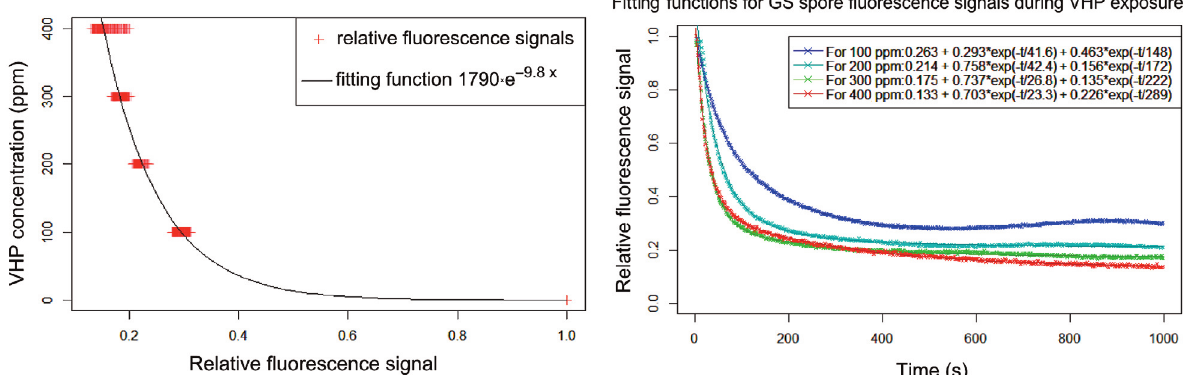
Fig. 4. Left graph – VHP concentration values plotted as a function of the relative fluorescence intensity levels (compared to the initial fluorescence level) that were recorded after >5 minutes from the beginning of VHP exposure. The single exponential fitting seems to describe really well the GS spores during the VHP decontamination process. Right graph – intensity of relative fluorescence levels in the Trp-like spectral region as a function of time at 100 ppm, 200 ppm, 300 ppm and 400 ppm VHP concentrations. Data was measured in real time after placing the samples (t = 0) in the experimental room where VHP decontamination was carried out. The values of biexponential fitting functions are also shown in the legend of the graph and in Table 2.